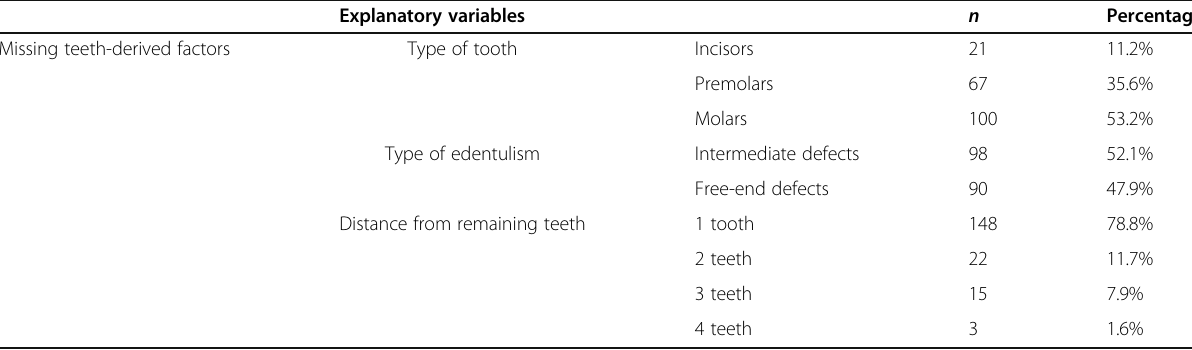
Explanatory variables